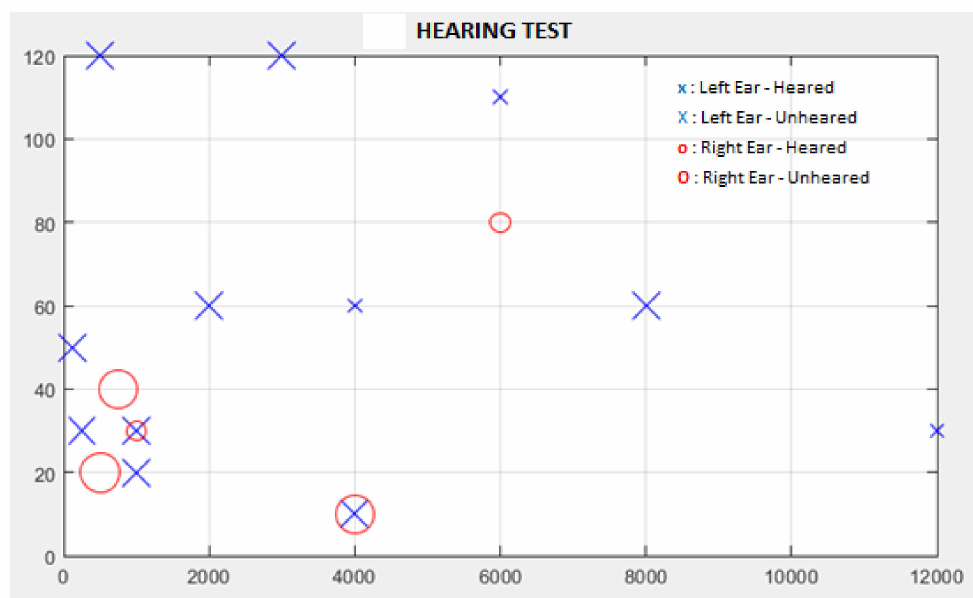
Figure 4. Representative audible and unheard sounds during the test.